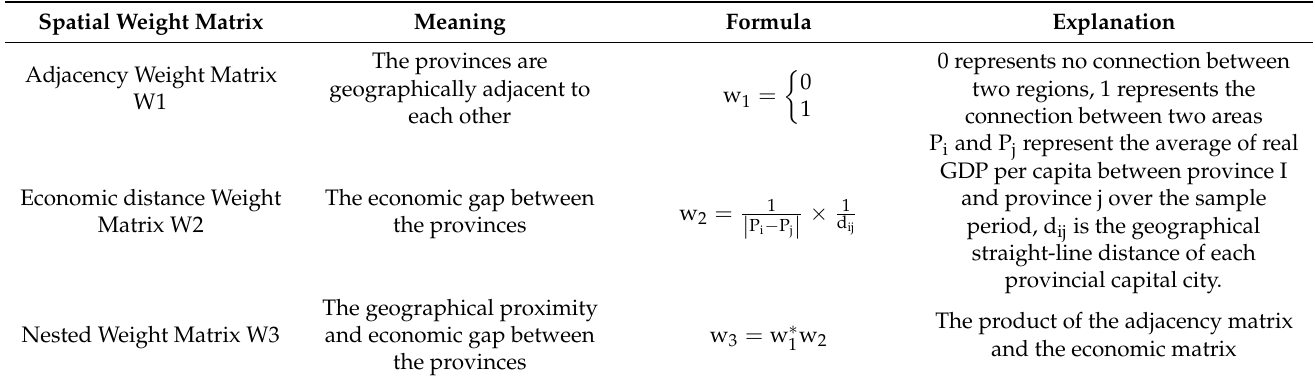
Table 1. Weight matrix description.